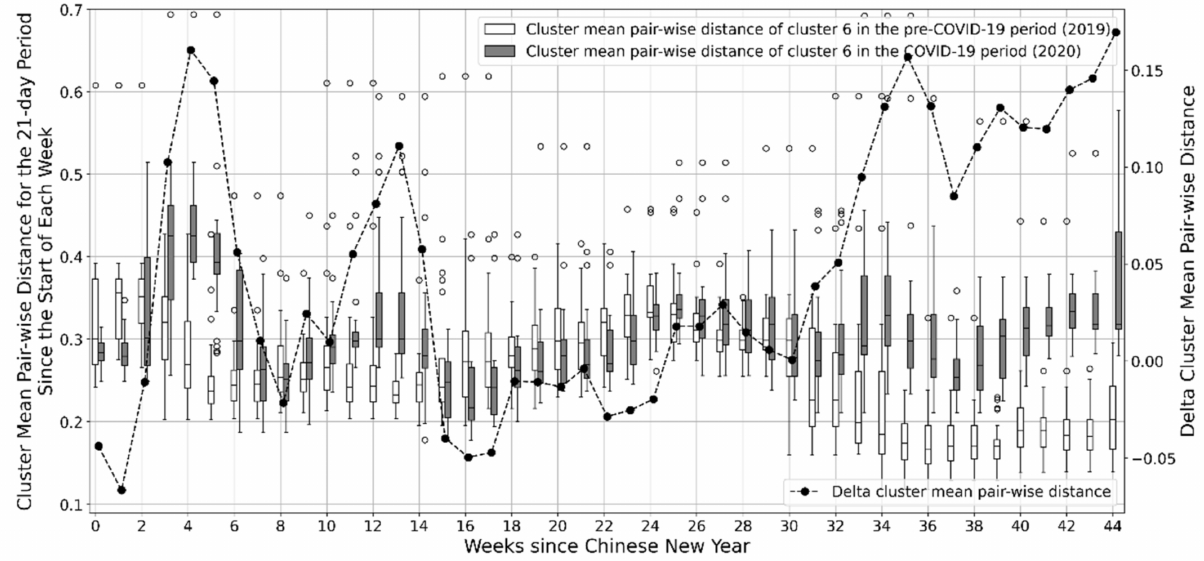
Figure 12. Boxplot comparison of the cluster mean pairwise distance of cluster 6 between the COVID-19 period and the pre-COVID-19 period (each green or blue boxplot represents the cluster mean pairwise distance for the 21-day period from the indicated week on the x -axis; delta cluster mean pairwise distance is the difference between the cluster mean pairwise distance of the COVID-19 period and the pre-COVID-19